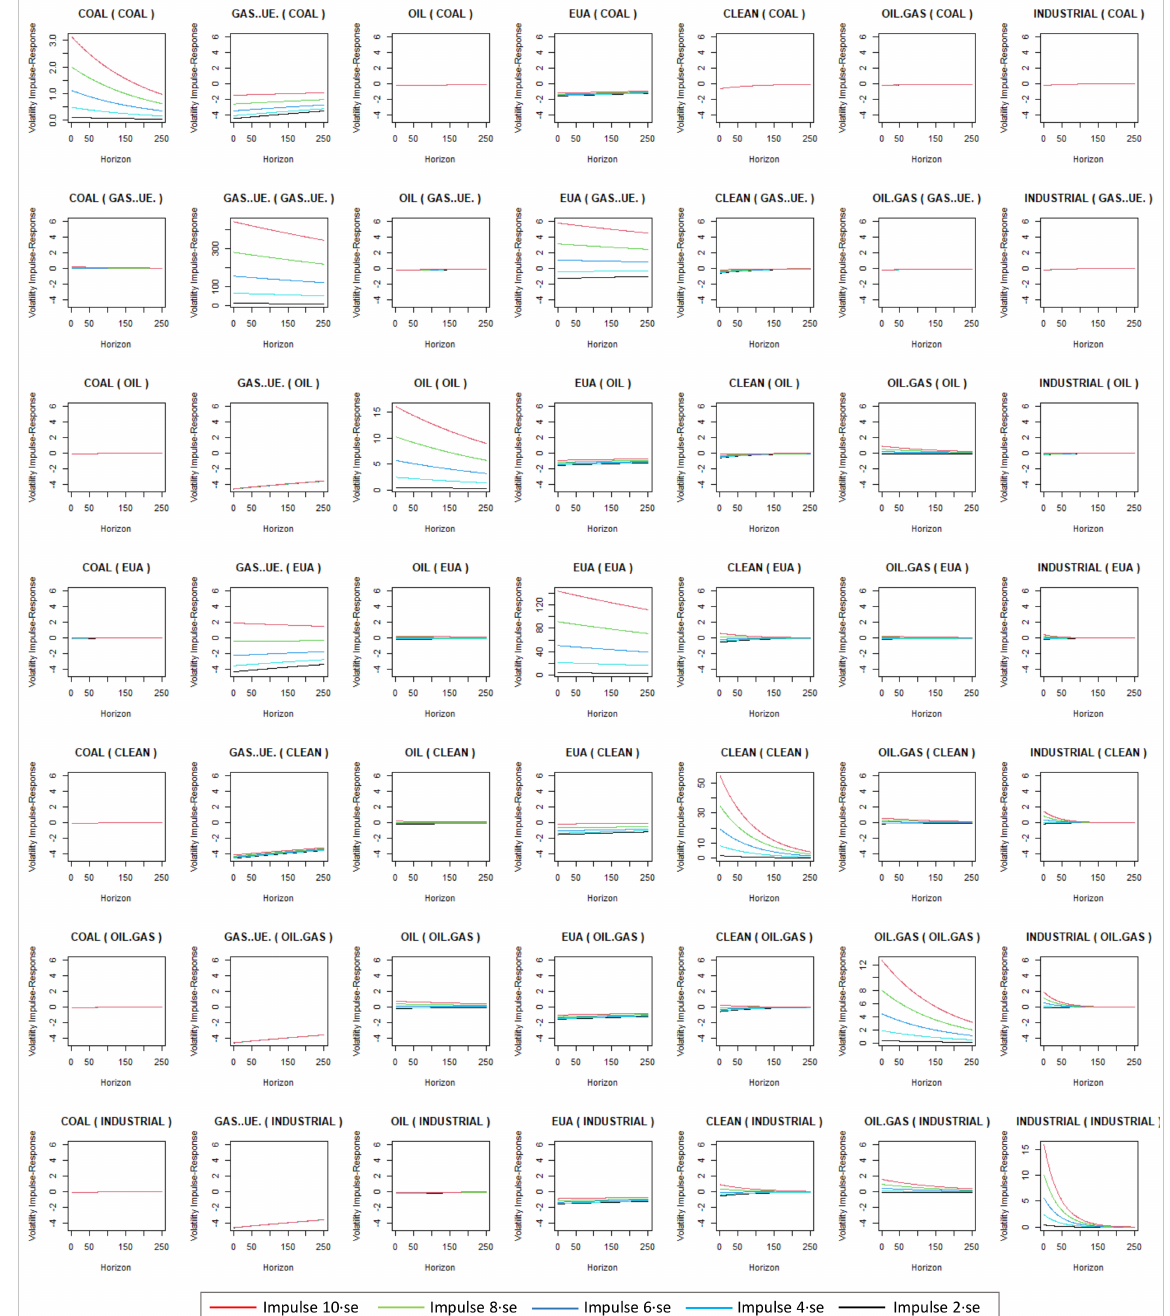
Figure 7. Matrix graph with the volatility impulse response curves for several forecast horizons and shock sizes. The off-diagonal cells contain the response of the conditional volatility of one variable when the shocked variable is a different one and the diagonal cells enclose the responses when the shocks are produced on itself (the shocked variable in